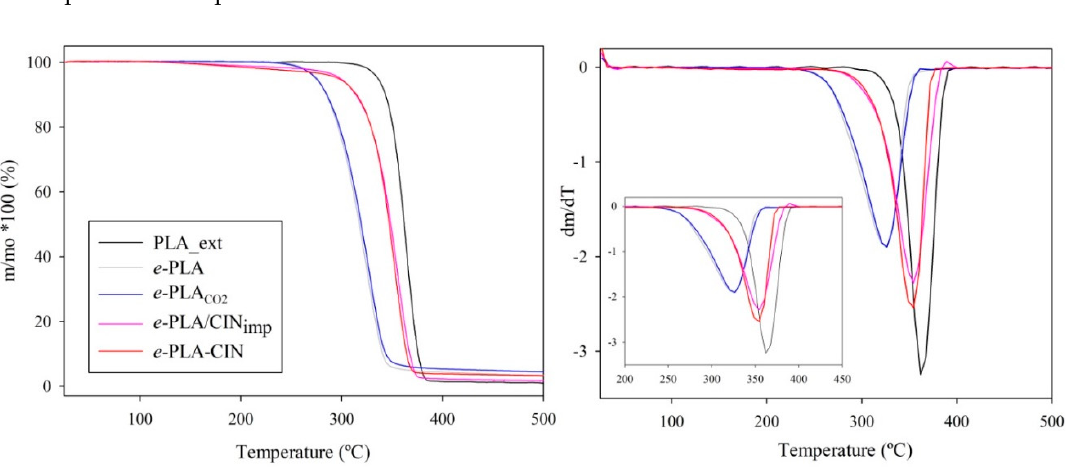
Figure 5. ( Left ) TGA curves of PLA materials. ( Right ) Derivative plots of TGA (DTGA) of PLA-based materials. Insert: Zoom between 200 °C and 450 °C.